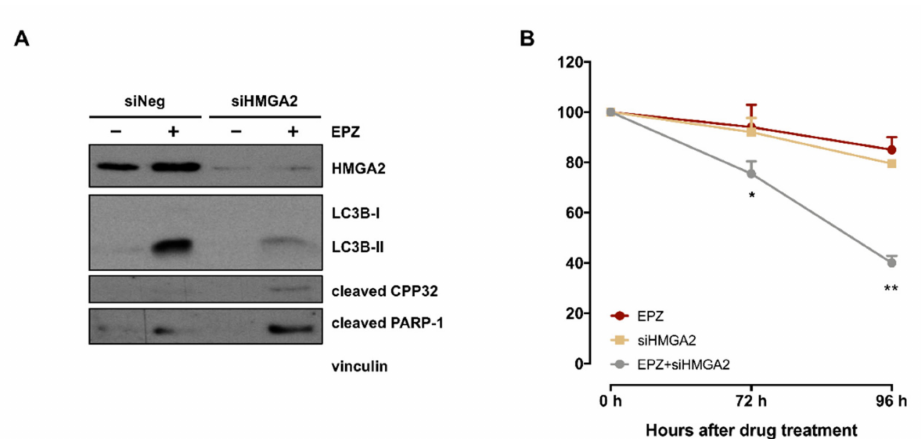
Figure 5. E ff ects of HMGA2 silencing on EPZ-011989-induced autophagy in a PDX-derived ES-1 cell line. ( A ) Western blots showing the expression of HMGA2, LC3B, cleaved PARP-1 and cleaved caspase 3 (CPP32) in untreated and EPZ-011989 (100 µ M for 96 h)-treated ES-1 cells after transfection with siHMGA2 or siNeg. Cropped images of selected proteins are shown. A representative Western blot of three independent experiments is shown. ( B ) Cell growth inhibition curves obtained after exposure to 100 µ M EPZ-011989 of ES-1 cells transfected with siHGMA2 or siNeg. Data are reported as a percentage of EPZ-011989-treated cells (mean ± SD of three independent experiments) compared with untreated siNeg cells. * p < 0.05; ** p <